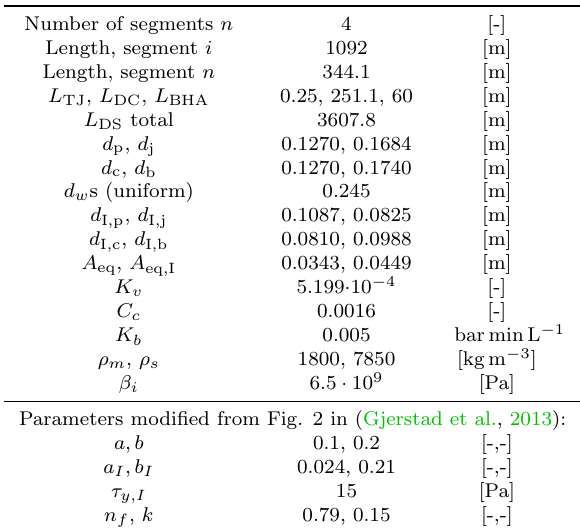
Table 2: Wellbore and drill string data. TJ - Tool joint, DC - drill collar.